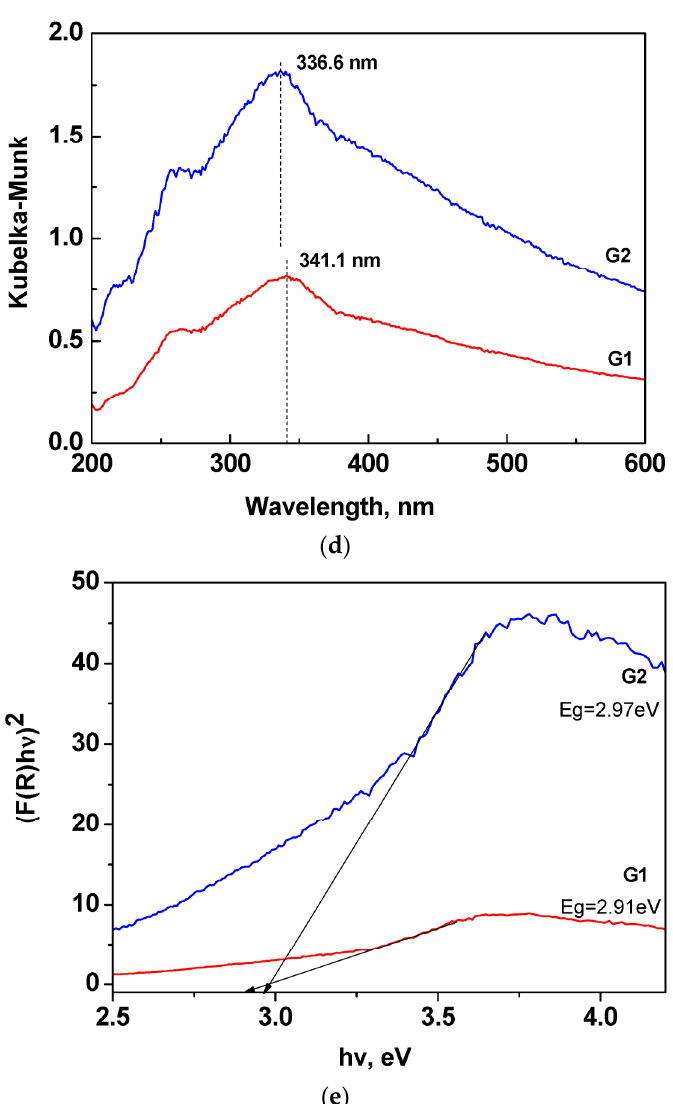
Figure 10. XPS spectrum of the photocatalyst: survey scan: ( a ) deconvoluted O1s peak, ( b ) absorbance spectrum, ( c ) absorbance spectrum with Kubelka–Munk transformation, ( d ) Tauk plot from UV-Vis analysis ( e ) of Mentha arvensis -mediated ZnO